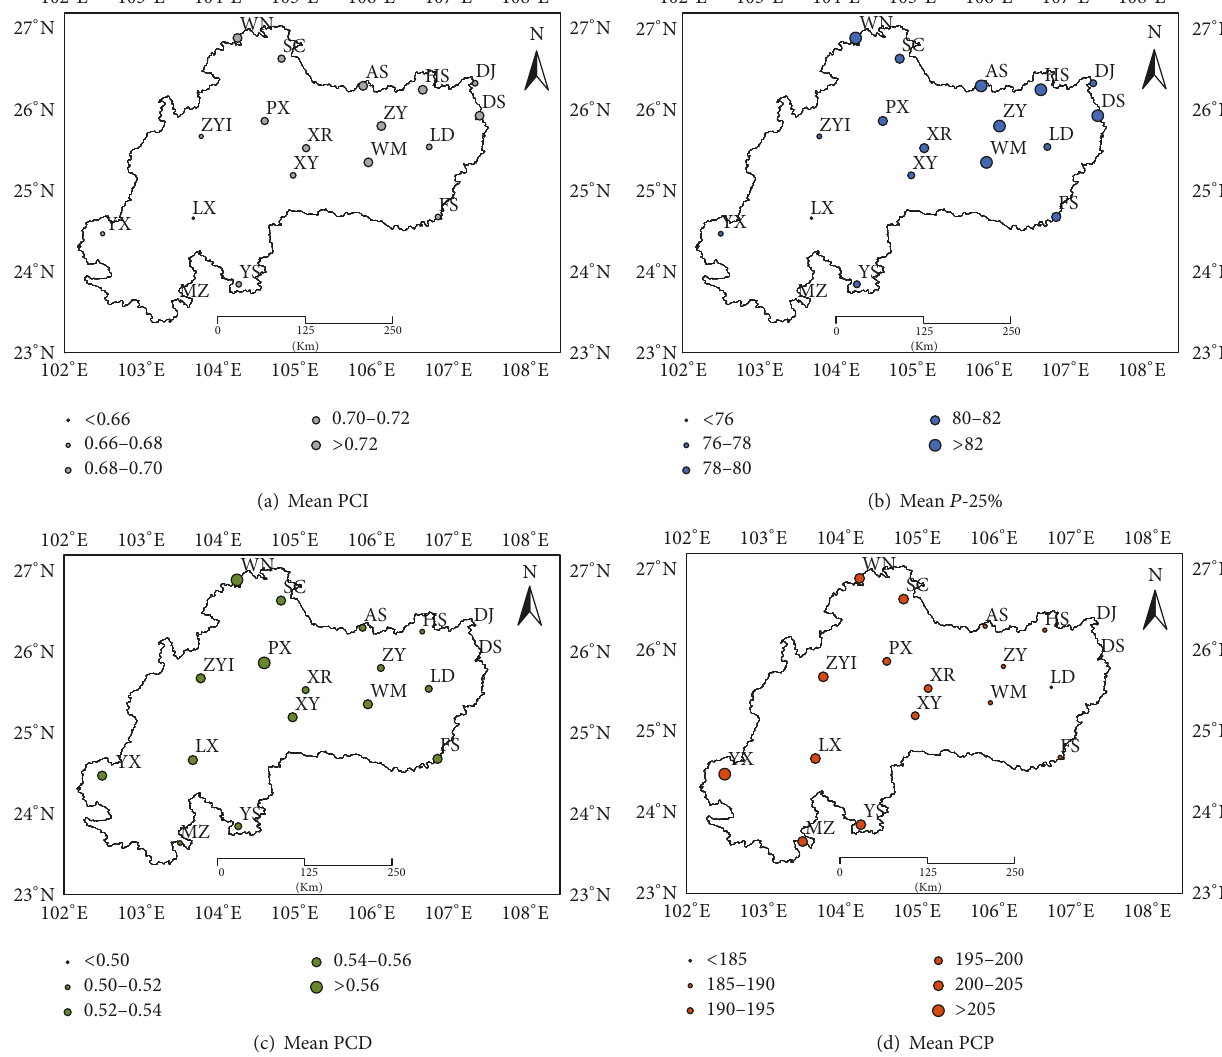
Figure 3: Spatial distribution of the mean annual precipitation concentration index (PCI) (a); mean annual percentage of precipitation contributed by the top 25% of rainy days ( 𝑃 -25%) (b); mean annual precipitation concentration degree (PCD) (c); and mean annual precipitation concentration period (PCP) (d) in the UHRB from 1959 to